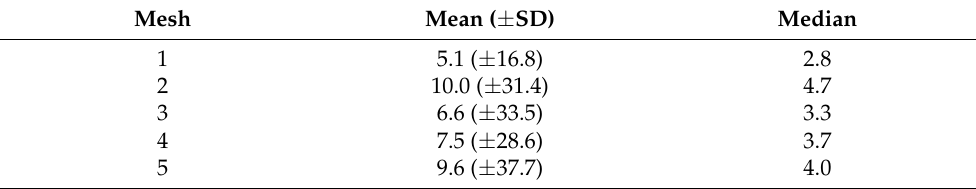
Table 1. Descriptive statistics for evaluating the precision of the laboratory scanner.